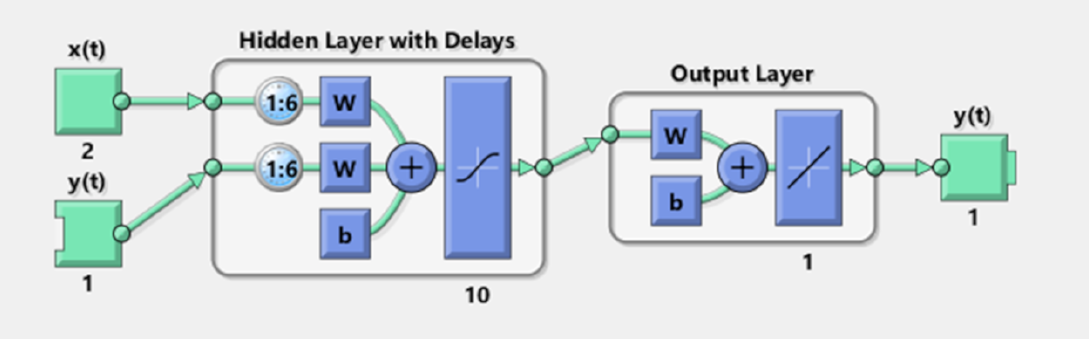
Figure 2. Neural network created in Matlab